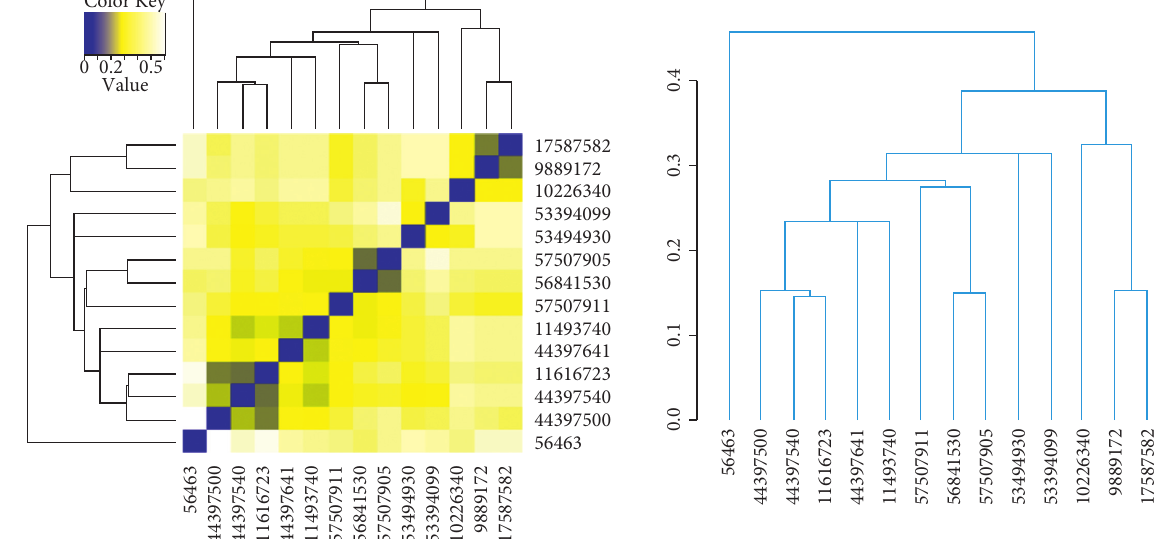
Figure 8: The heat map and dendrogram for Groups 1 and 2.